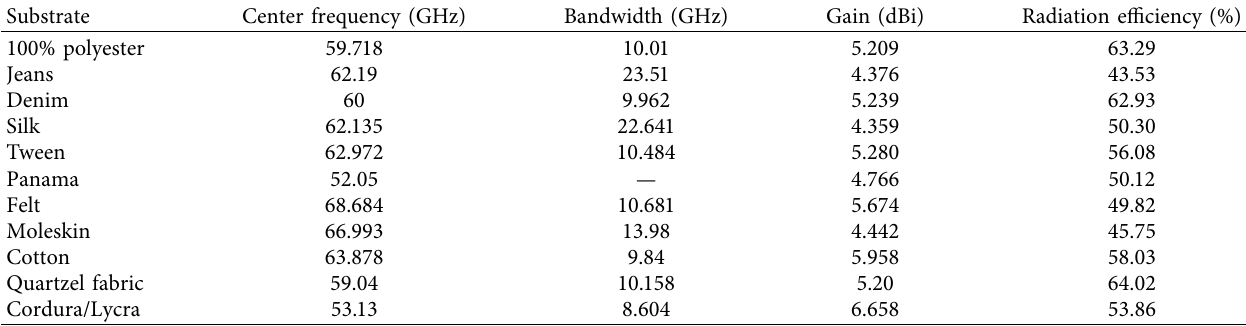
Table 10: Different textiles performance summary at 2mm away from phantom.